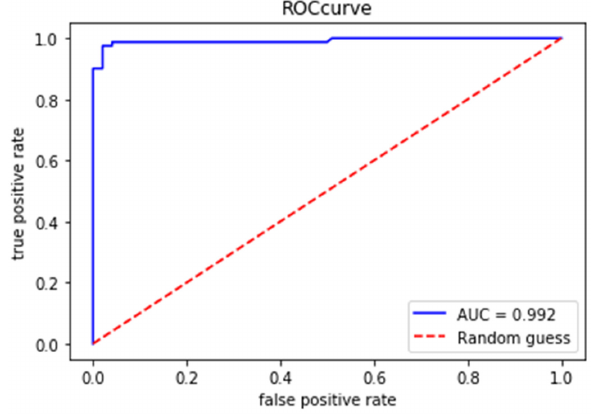
Figure 8. ROC curve.